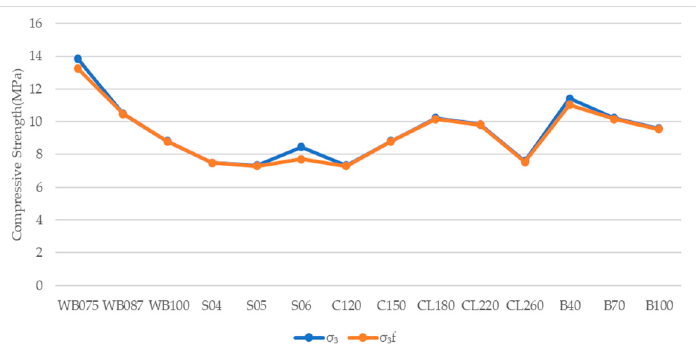
Figure 4. Comparison of Peak Compressive Strength between Calculation and Test with Confining pressure (0.4 MPa, 0.6 MPa).